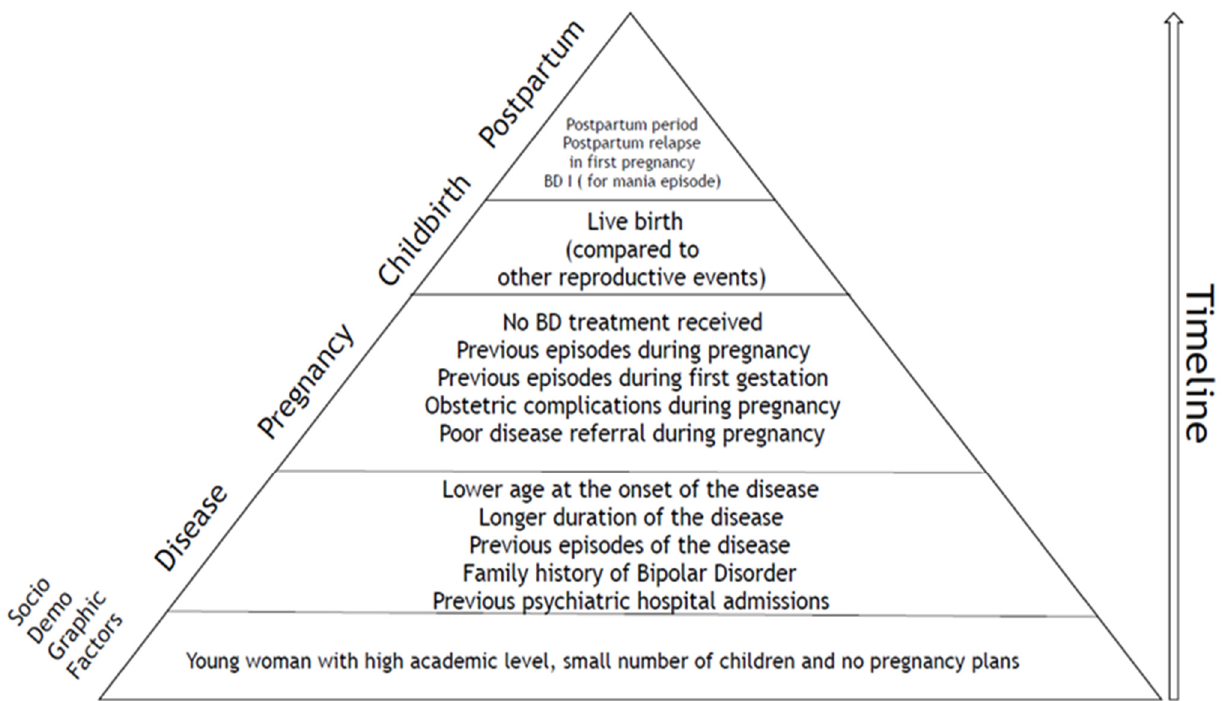
Figure 2. Risk factors for postpartum relapse in patients with bipolar disorder extracted from the selected articles.